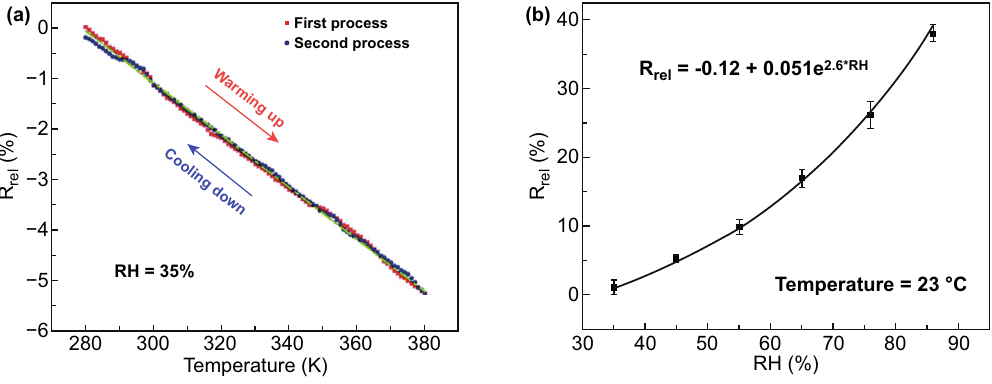
Fig. 19 a Hybrid NCs-rGO film temperature sensitivity by (R rel ) changes in the temperature range of 280–380 K. b NCs-rGO hybrid film humidity sensitivity in a variation of (RH: 30–90%). Reproduced with permission from Ref. [32] Copyright © 2018, The Royal Society of